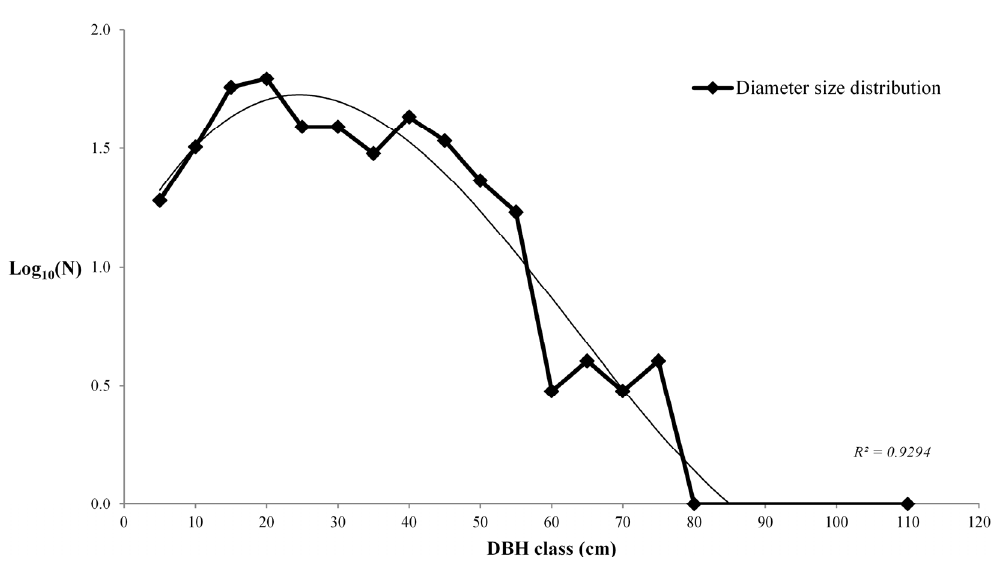
Figure 3. Diameter frequency distribution of all the living stems.